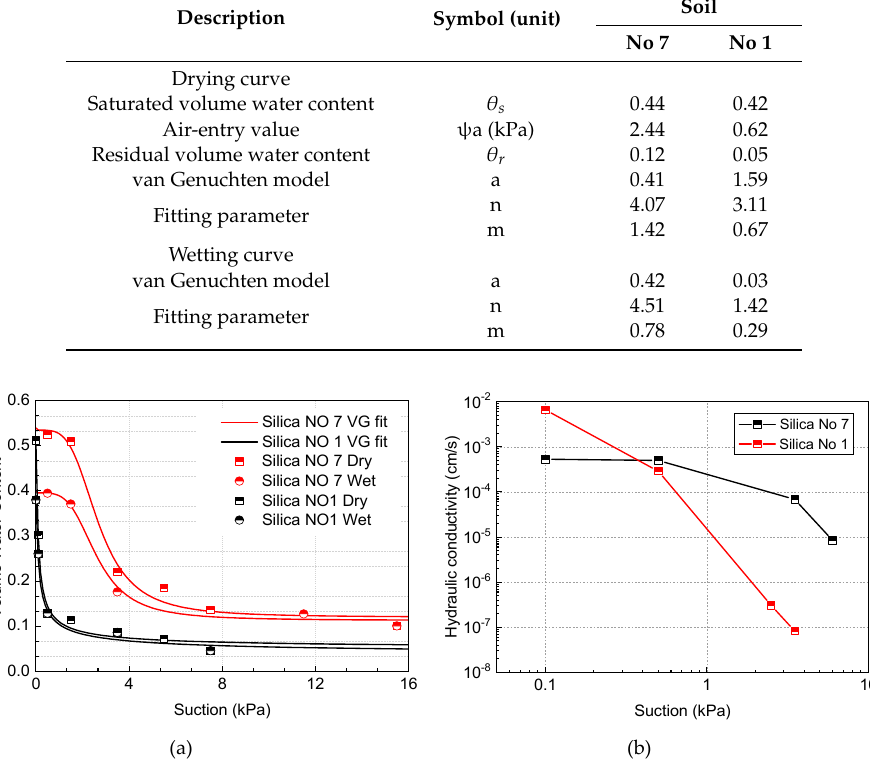
Table 2. Hydraulic properties of sand materials.